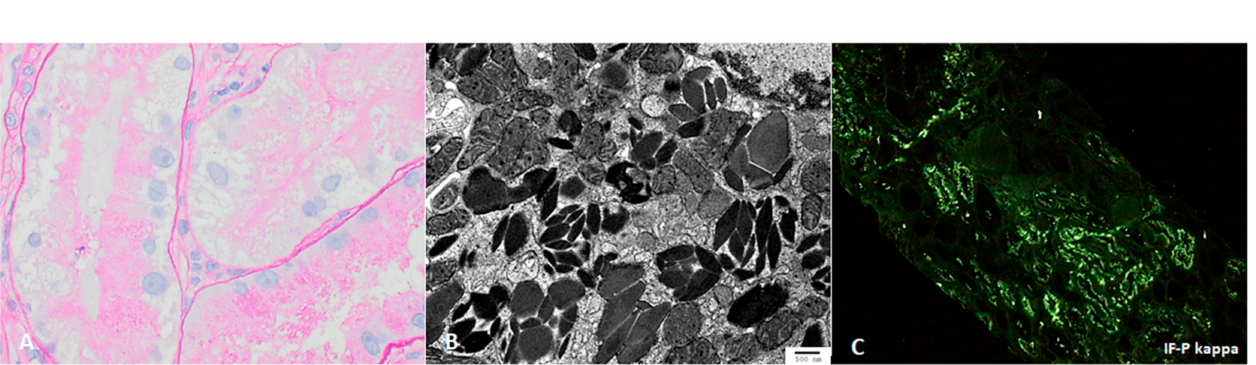
Figure 2. Light chain proximal tubulopathy, with rhomboid-shaped intratubular crystals (( A ) PAS 600 × and ( B ) transmission EM, direct mag 14,000 × ), which stain for ( C ) only kappa light chain, by